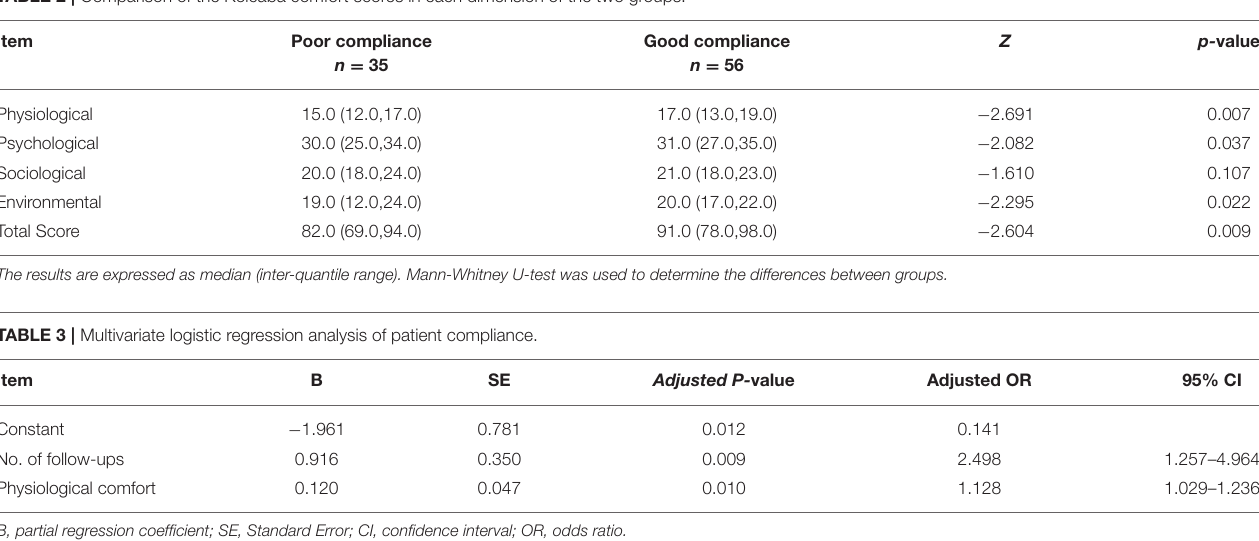
TABLE 2 | Comparison of the Kolcaba comfort scores in each dimension of the two groups.